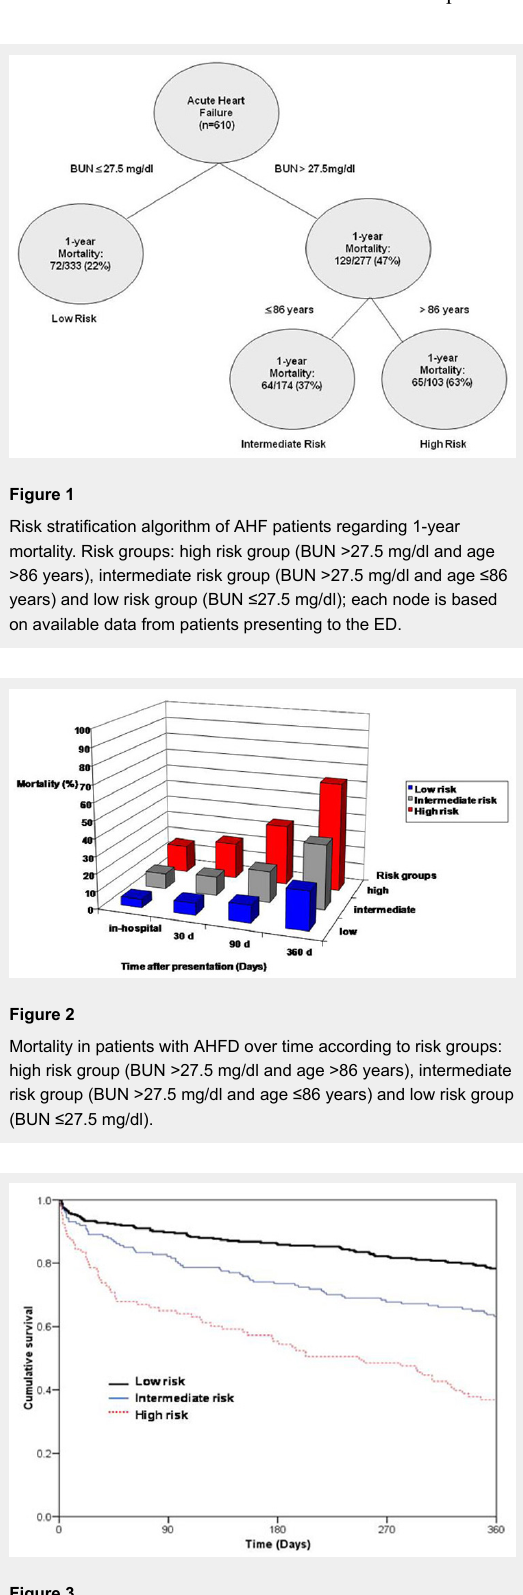
Kaplan-Meier curves demonstrating cumulative survival in patients with AHF over time according to risk groups: high risk group (BUN >27.5 mg/dl and age >86 years), intermediate risk group (BUN >27.5 mg/dl and age ≤86 years) and low risk group (BUN ≤27.5 mg/ dl); p <0.001 by